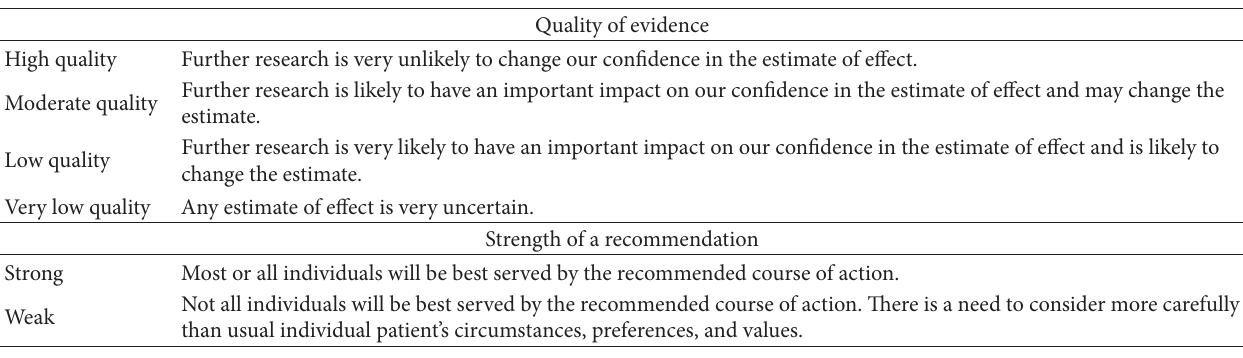
Table 1: Quality of evidence and strength of a recommendation.